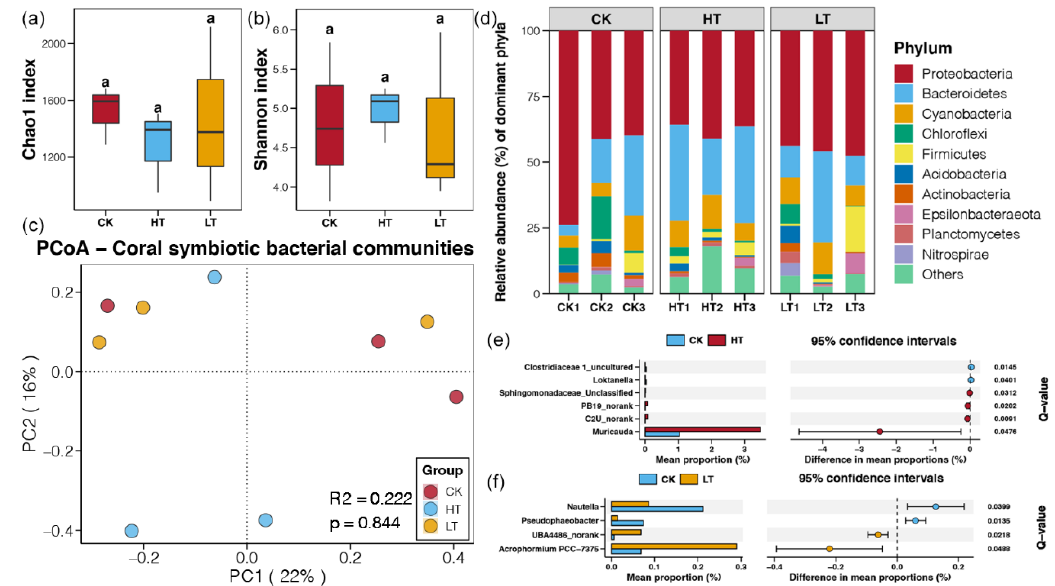
Figure 2. Responses of symbiotic bacterial communities under different temperature stresses. ( a ) Differences of Chao1 index among different groups. ( b ) Differences of Shannon index among dif- ferent groups. Different lowercases letters above each box in the same subfigure represent signifi- cant differences between groups (Student’s t -test, p < 0.05). ( c ) PCoA and PERMANOVA of the sym- biotic bacterial communities of corals under different temperature stresses. ( d ) The relative abun- dances of dominant phyla in the symbiotic bacterial communities of corals under different temper- ature stresses. ( e ) Bacteria with significantly different abundances in between corals from the HT and CK groups. ( f ) Bacteria with significantly different abundances in between corals from the LT and CK groups.